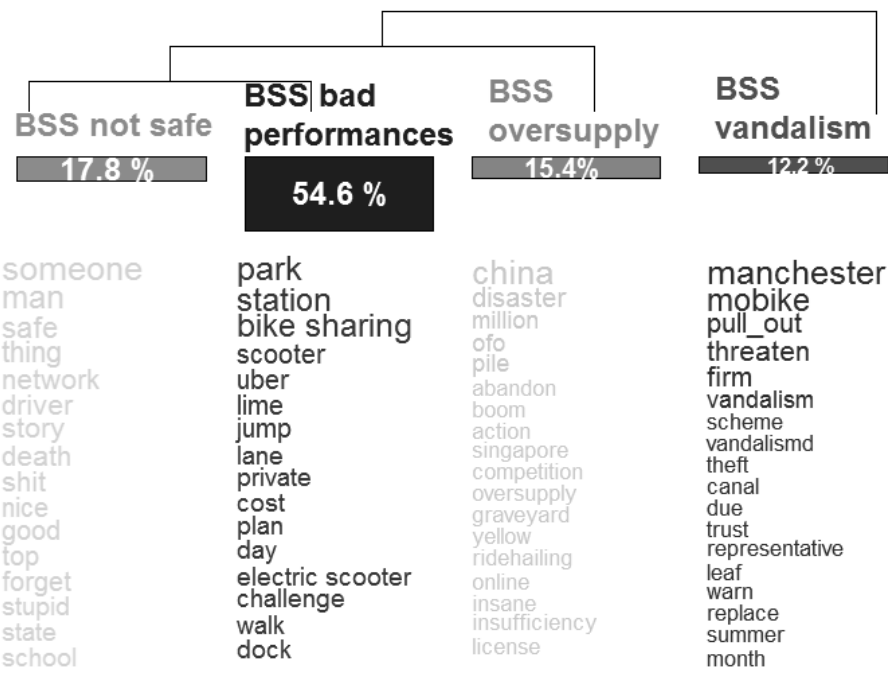
Figure 7. Quantitative topic clustering on strongly negative tweets Around 24% of the negative tweets were related to Asian start-ups of dockless systems, and specifically to the companies “ofo” and “mobike”. The predominant cluster (28.9%) was related to tweets describing BSS that have experienced poor performance or that have been pulled out from a city. The other main categories are related to vandalism issues to the bike-sharing infrastructure, mainly bicycles, and also complaints about the oversupply of some systems and the bicycle graveyards. Another cluster included the unsatisfactory deployment of the system, even approaching equity issues, issues by using or renting bicycles, and safety issues. Finally, the least frequent clusters dealt with complaints to public authorities and the lack of BSS in their cities. Table 2 shows examples of the strongly negative tweets per cluster.